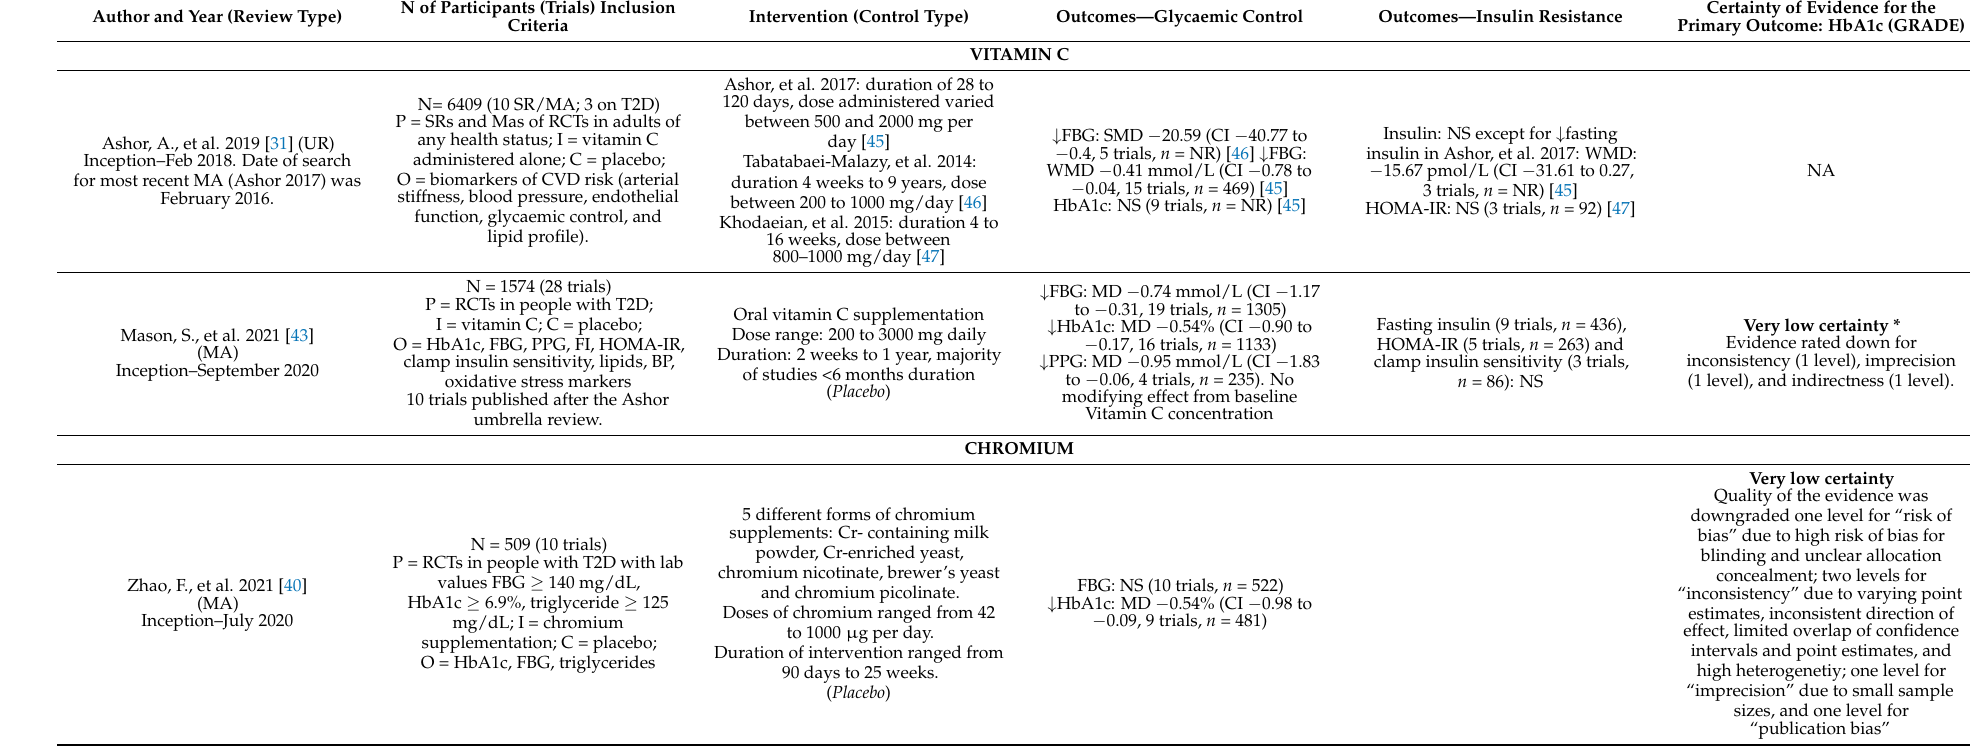
Table 1. Characteristics and main findings of reviews